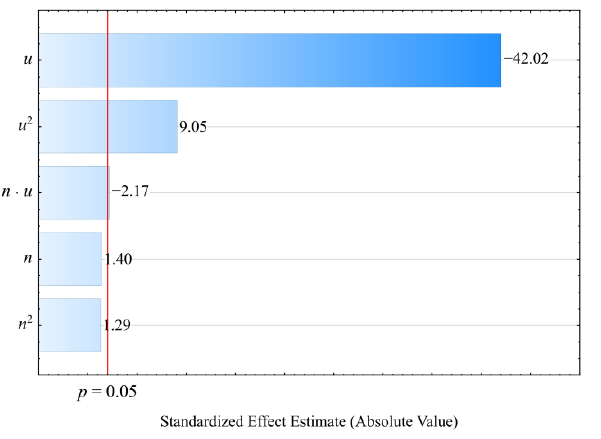
Figure 18. Pareto plots of the standardized effects of empirical full model impact strength; the vertical line in the plot corresponds to the arbitrarily chosen level of significance ( p = 0.05). Table 12. Model of impact strength—ANOVA table, R 2 = 0.98; R adj2 =